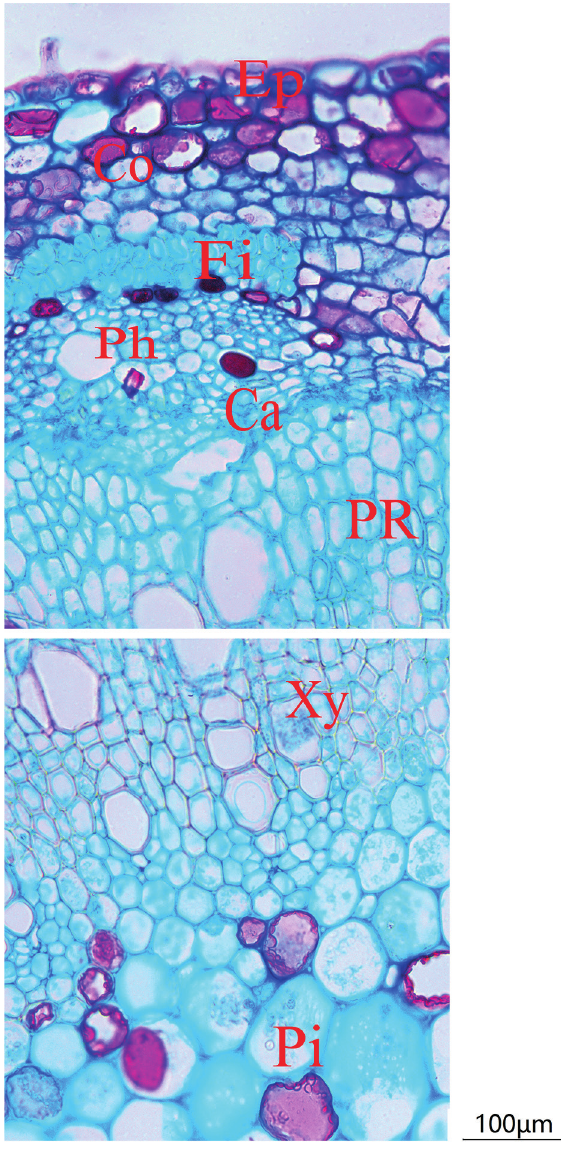
Figure 4 - Transverse section of stem. Ep: epidermides; Co: cortex; Fi: fibre; Ph: phloem; Ca: cambium; PR: pith ray; Xy: xylem; Pi: pith. Bars: 100